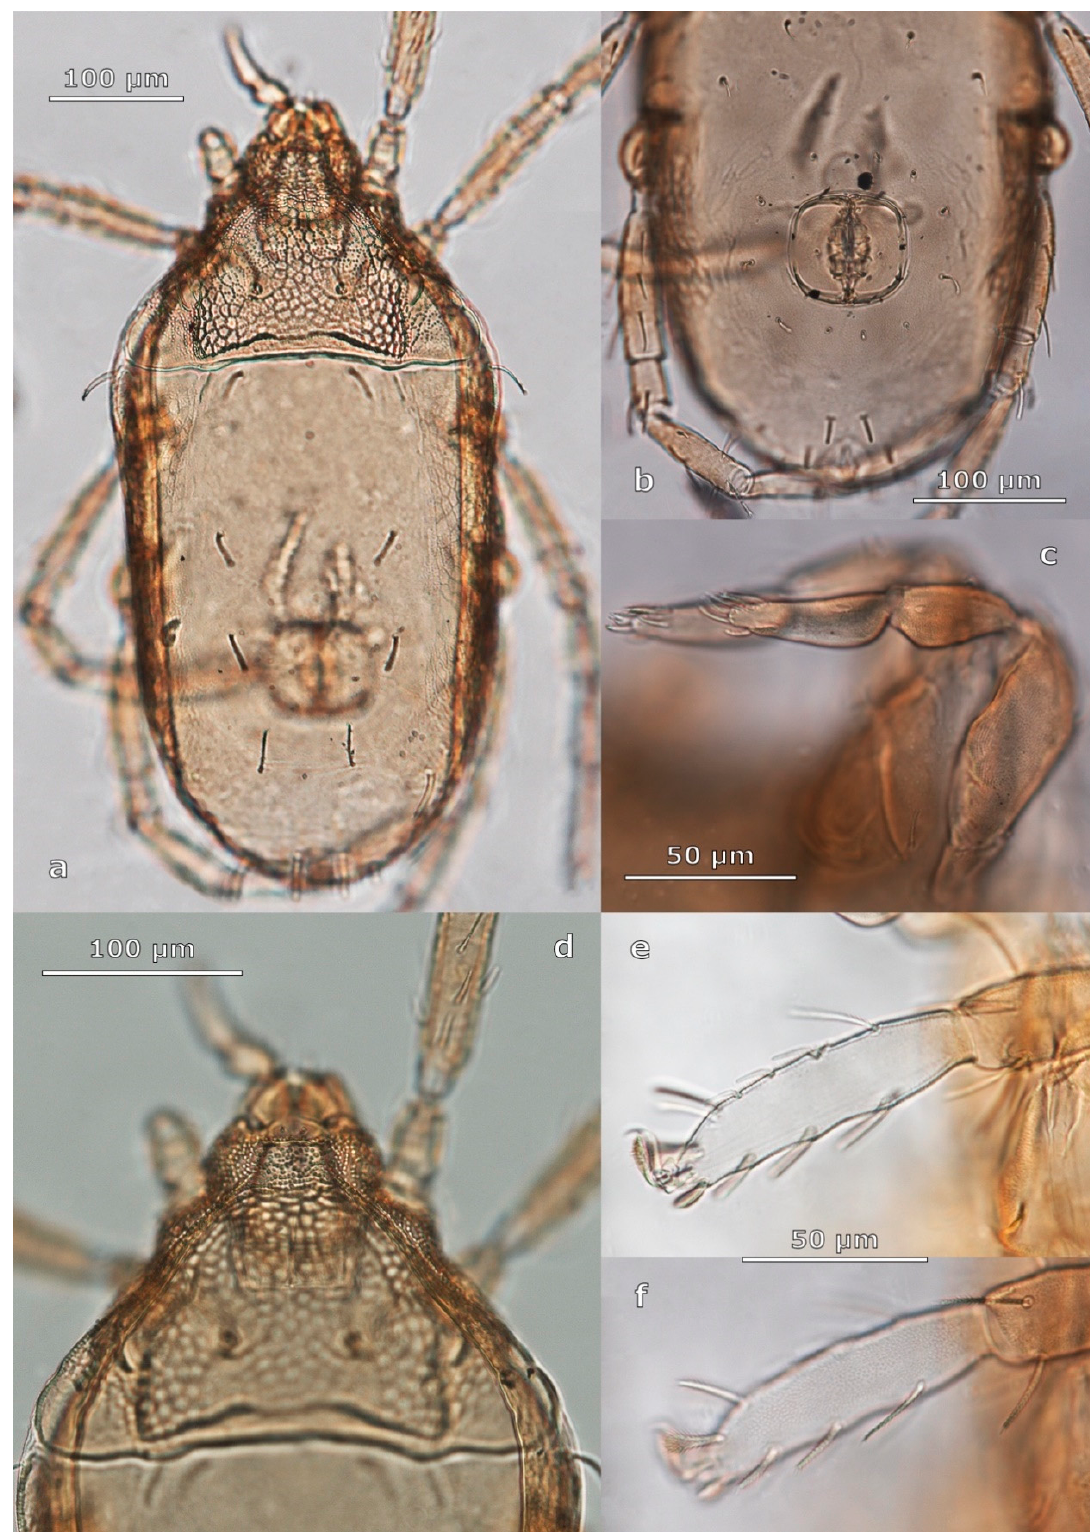
Figure 8. S. nunatakis sp. nov. ( a ) dorsal view; ( b ) ventral view with evident circular camerostome and visible asymmetry of the aggenital setae; ( c ) detail of the pedipalps; ( d ) detail of the propodosoma; ( e ) lateral view of the rhagidial organs on tarsus II and ( f ) clavate setae on top of tarsus II.